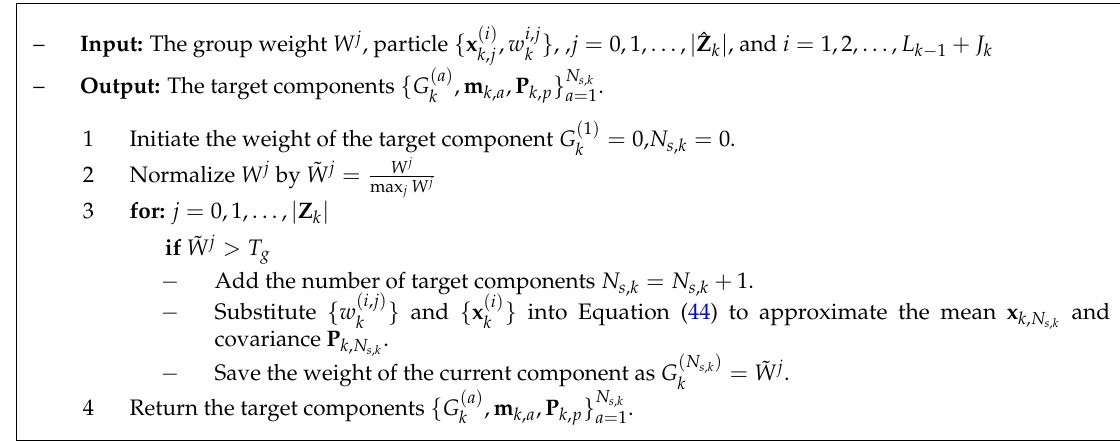
Table 3. The construction of target